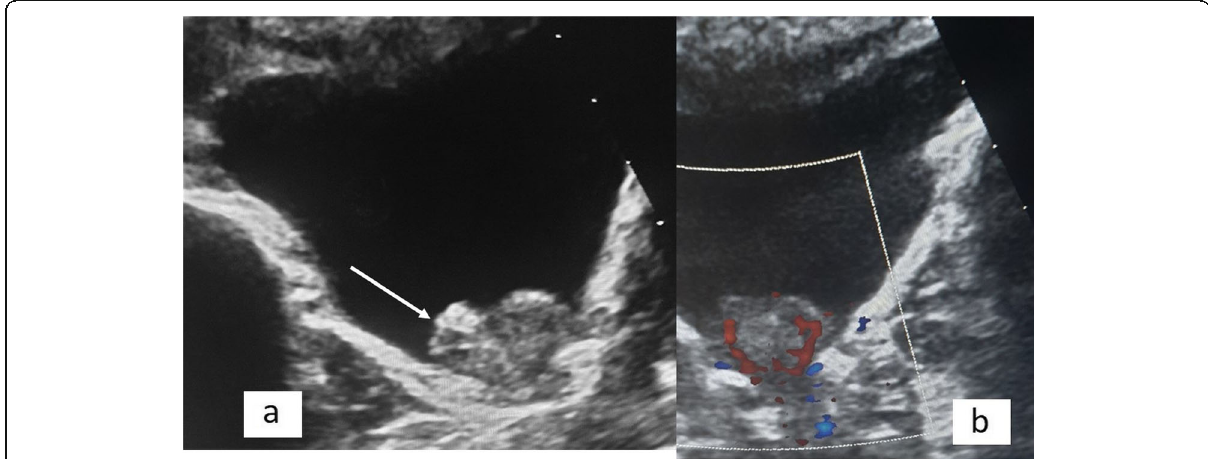
Fig. 1 Transverse grayscale ultrasound ( a ) and color Doppler ( b ) image through the pelvis show well-marginated hypoechoic mass lesion (arrow in a and b ) arising from the bladder neck projecting into the bladder lumen. The lesion shows mild